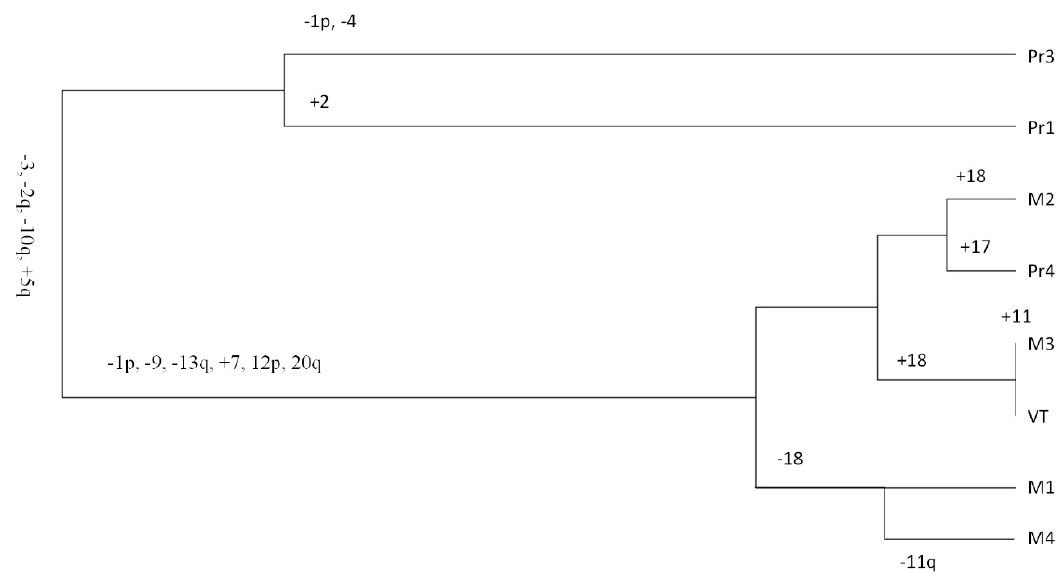
Figure 2. Phylogenetic tree based on copy number alteration (CNA) characteristics from different tumour samples of ccRCC patient 1 (RC1). Abbreviations: Pr1, primary tumour 1; Pr3, primary tumour 3; Pr4, primary tumour 4; VT, inferior vena cava tumour thrombus; M1, metastasis 1; M2, metastasis 2; M3, metastasis 3; M4, metastasis 4.